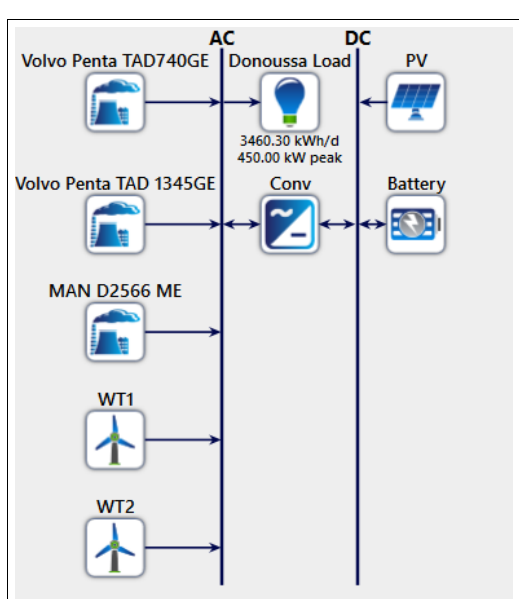
Figure 6. Scenario 2 Homer Pro Configuration.